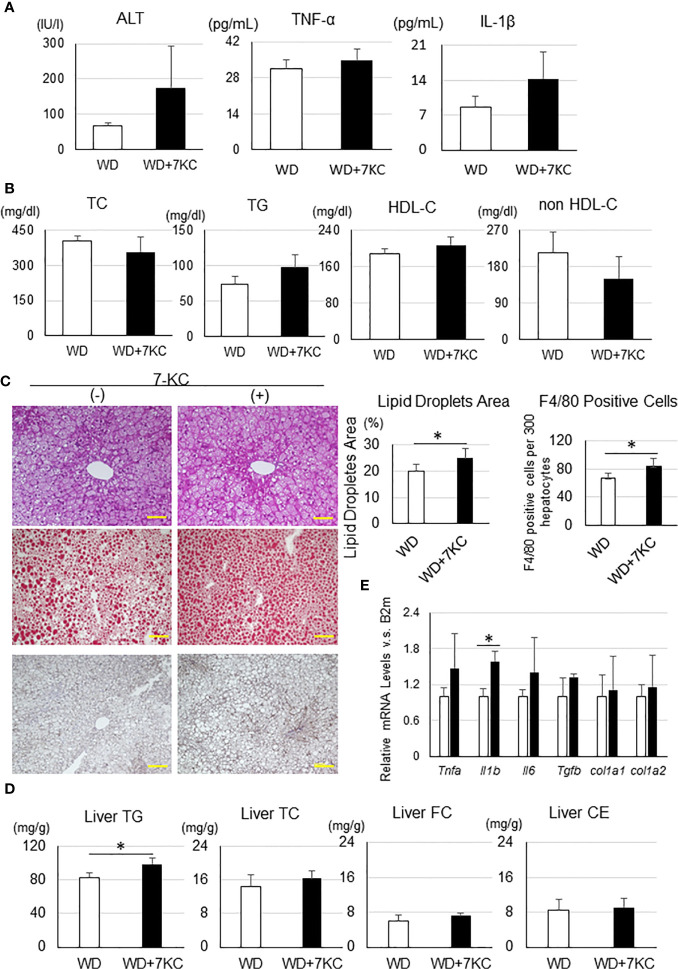
Effect of 7KC on body and organ weight, ALT, lipid profiles, liver histology, hepatic lipid content, and mRNA expression in db/db mice fed WD for 4 weeks. (A) Serum ALT, TNF-α, and IL-1β, (B) Lipid profiles, (C) HE staining, Oil Red O staining analysis, and F4/80 staining analysis, (D) mRNA expression, (E) Hepatic lipid analysis. All values are presented as the means ± SD. Student t test, n = 3 per group; *p < 0.05.